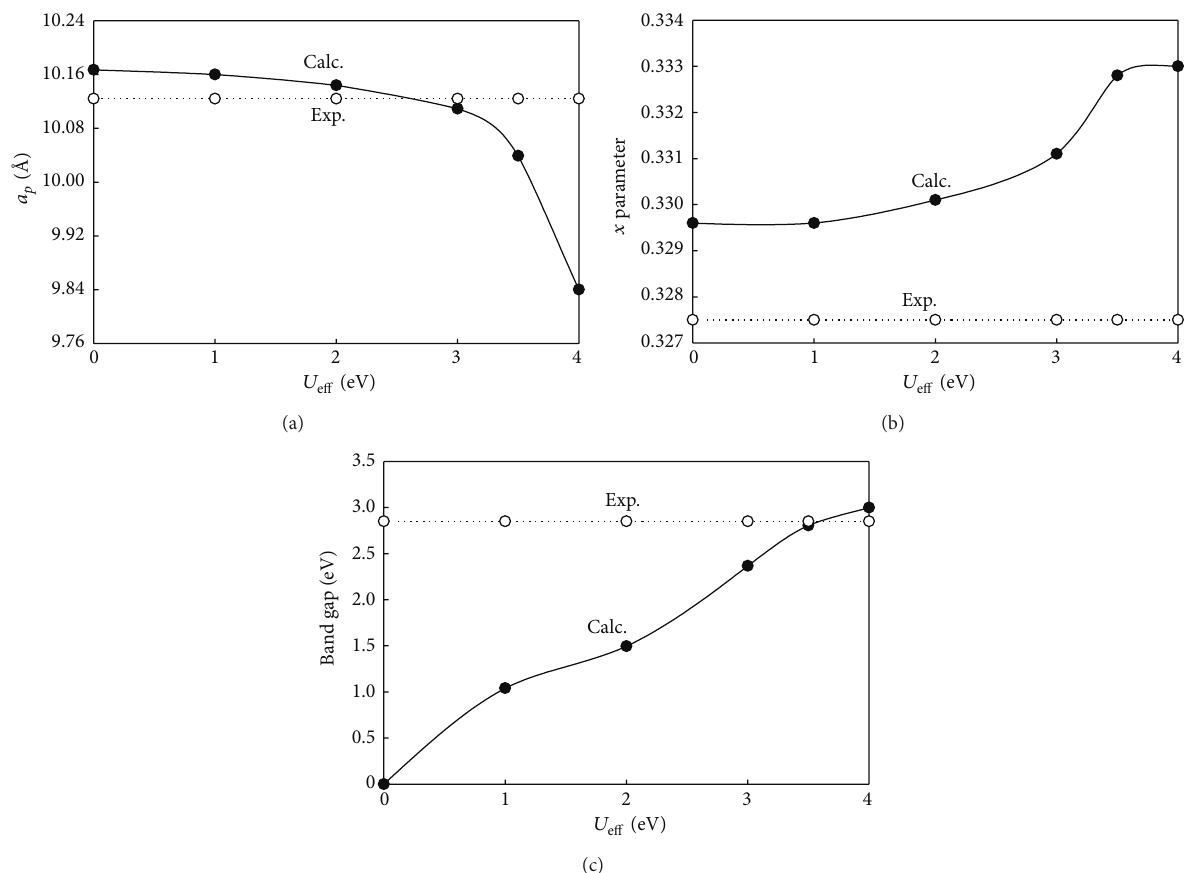
Figure 1: Dependence of the lattice parameter 𝑎 𝑝 (a), 𝑥 (b), and band gap (c) of the Dy 2 Ti 2 O 7 on 𝑈